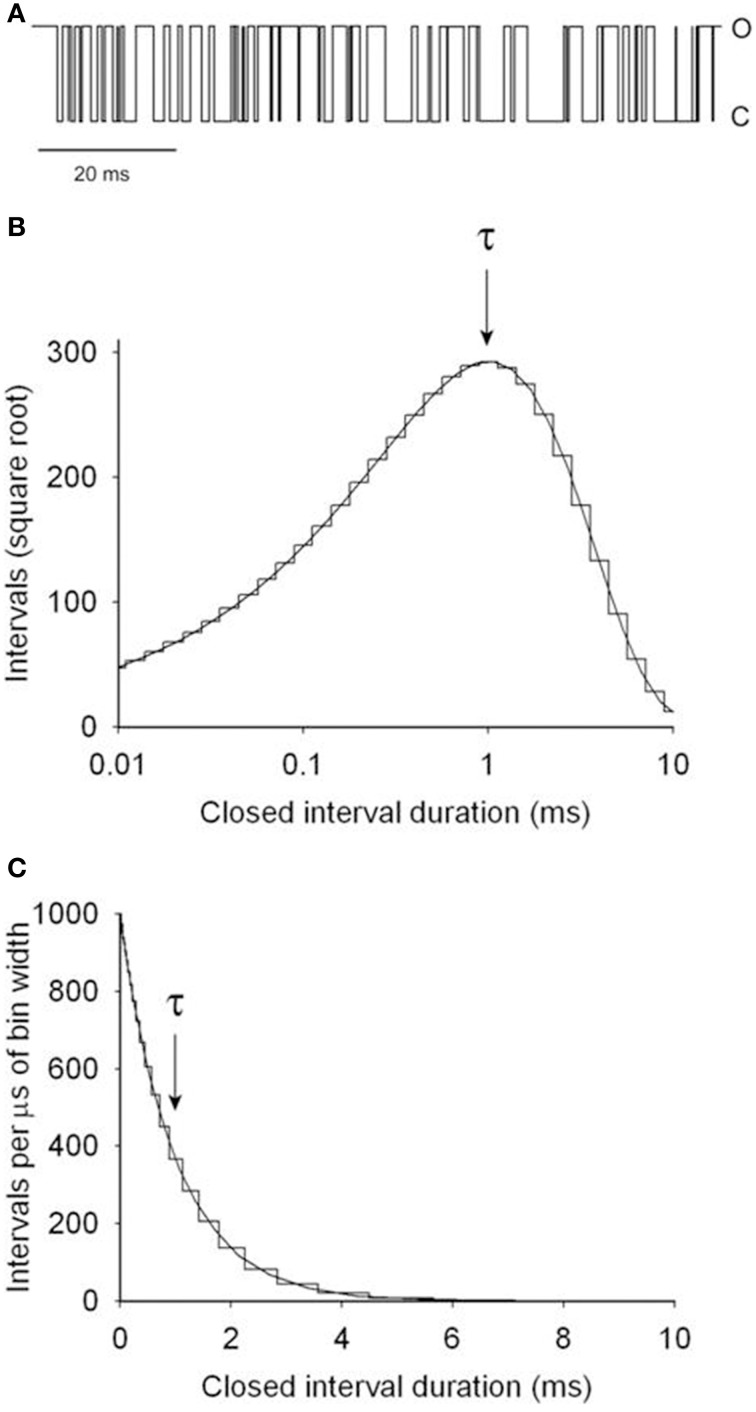
Simulated single channel kinetics for the two-state Scheme 1. (A) A simulated single-channel current record for Scheme 1 with opening and closing rate constants of 1000/s. (B) Dwell-time distribution of the closed interval durations plotted with the Sigworth and Sine transformation (Sigworth and Sine, 1987). The abscissa has log binning with 10 bins per log unit. The distribution peaks at the mean interval duration of 1 ms, indicated by τ. The rate constant for opening is given by the inverse of τ. (C) Dwell-time distribution of the same data in part B on a linear plot. The intervals were corrected for the increasing bin width that occurs with log binning. The mean interval duration τ is given by the time to decay to 1/e (1/2.718 = 0.368) of the initial amplitude. The same distributions would be obtained for the open intervals. 106 intervals were simulated and analyzed (from Shelley et al., 2010).